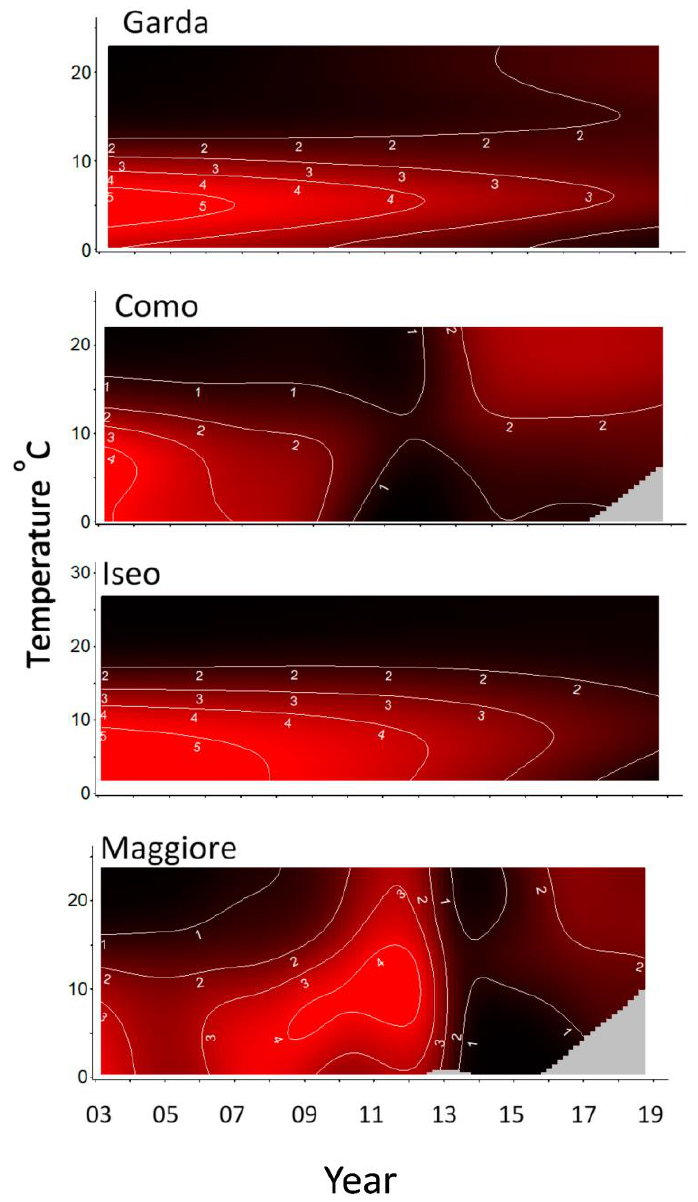
Figure 3. Model estimates (see Table 2) for chlorophyll-a μg L −1 (contour lines) against year and Temperature °C. Grey areas are outside model range.